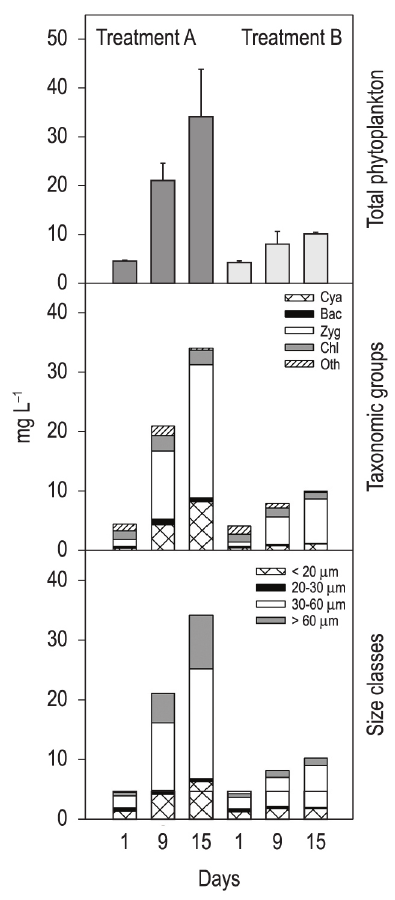
Figure 2. Mean and standard deviation of the total phy- toplankton biomass, taxonomic groups and size classes in the mesocosms on day 1 (start), 9 (middle) and 15 (end of the experiment). Treatment group (A= with fish), Control group (treatment B= no fish), Cya=Cyanobacteria, Bac= Bacillariophyceae (diatoms), Zyg=Zygnemaphyceae, Chl=Chlorophyceae, Oth=Others and size classes <20, 20-30, 30-60, >60